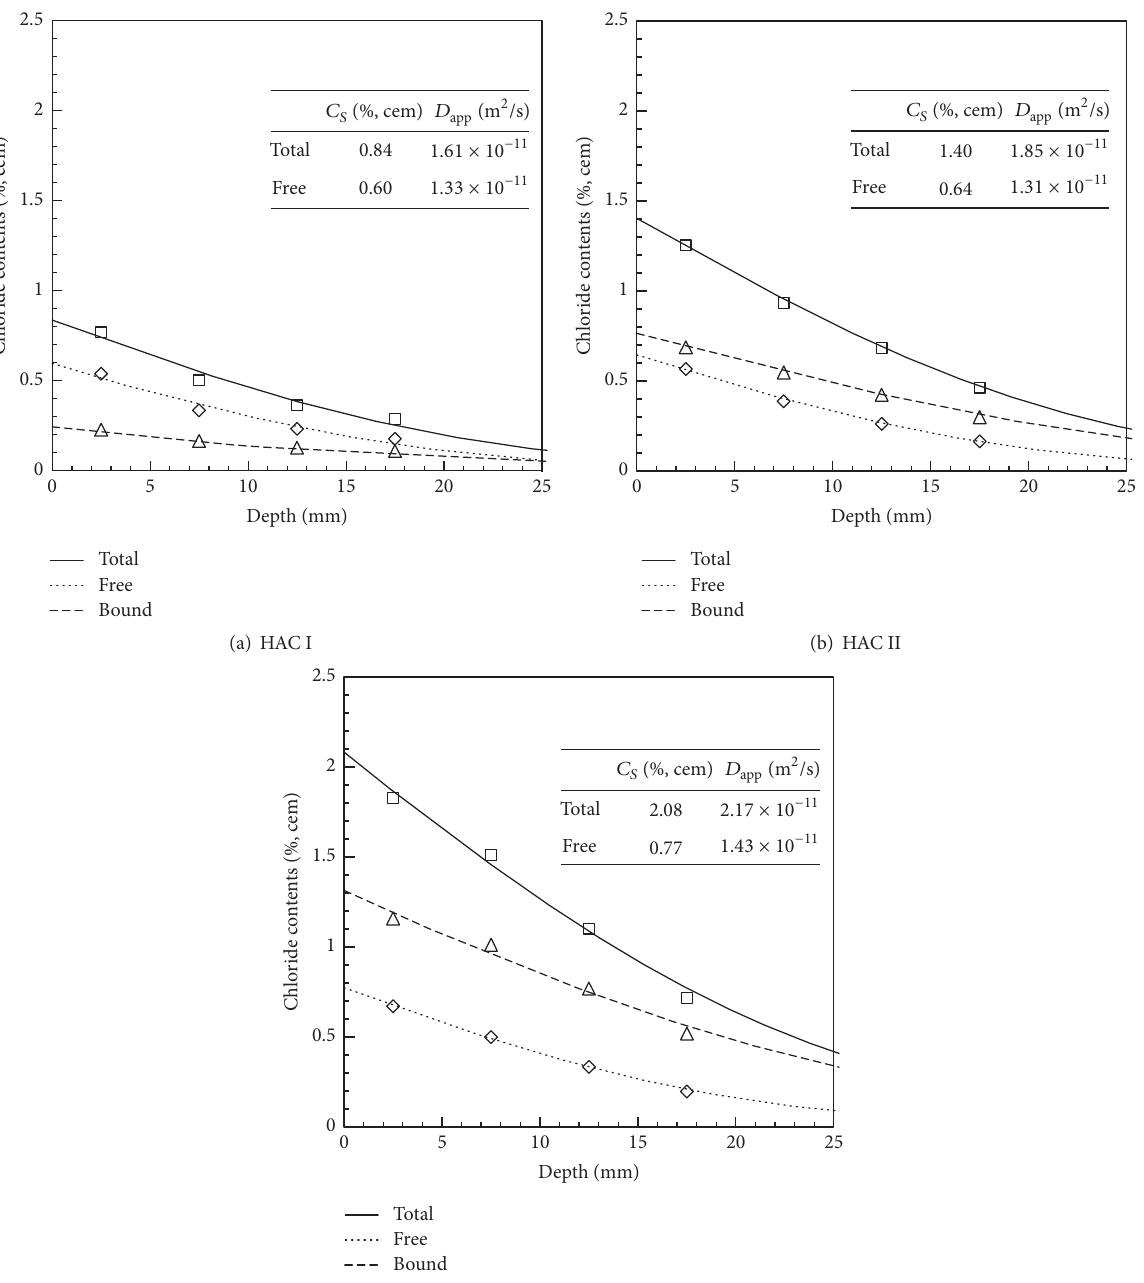
Figure 3: Chloride profiles of mortar for different HAC types after 100 days of exposure to 1.0M NaCl solution.